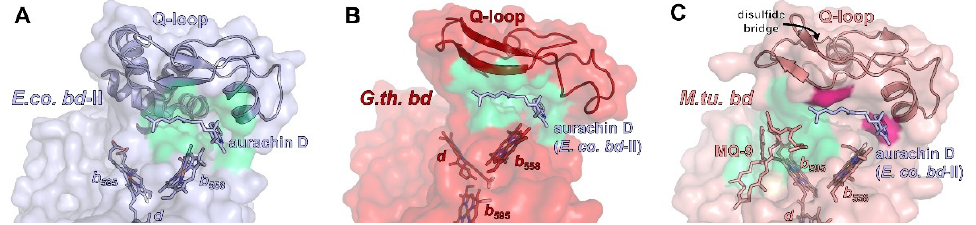
Figure 3. Quinol binding sites in bacterial bd oxidases. ( A ) Quinol binding site in E. coli bd -II (pdb ID 7OSE). The specific inhibitor aurachin D is shown as sticks, the interacting surface of CydA is shown in green, the residual protein surface in light blue. The Q-loop is involved in binding and provides the top half of the binding site. ( B ) Aurachin D (modelled from 7OSE after superimposing 5DOQ and 7OSE) perfectly fits to the putative quinol binding site in G. thermodenitrificans (5DOQ, green surface, residual protein surface given in red). ( C ) The corresponding cleft below the Q-loop in mycobacterial bd oxidases (shown for M. tuberculosis ) is too narrow for aurachin D (putative clashes shown in hotpink). Instead, a quinol binding site was identified close to heme b 595 , where menaquinone-9 was found to interact with CydA (green surface, residual protein surface in light